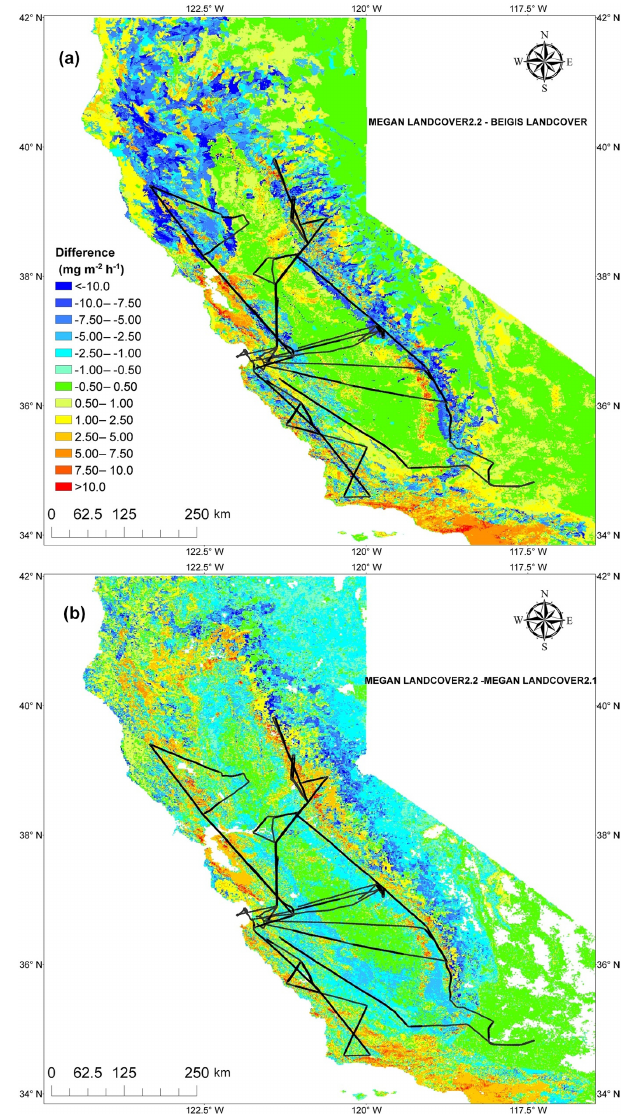
Figure 4. Absolute BEF differences of (a) MEGAN v.2.1 land cover v.2.2 and BEIGIS GAP land cover and (b) MEGAN v.2.1 land cover v.2.2 and MEGAN v.2.04 land cover